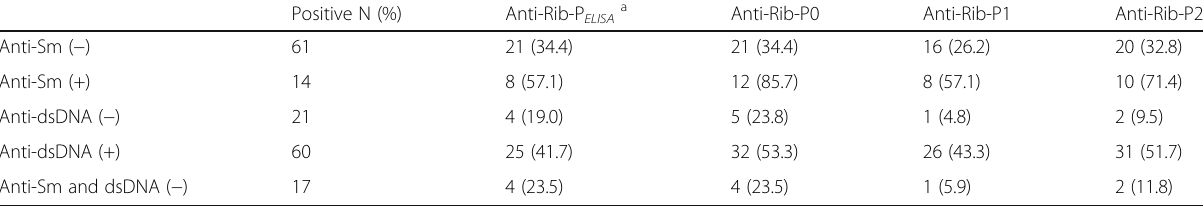
Table 2 Diagnostic benefit of autoantibodies against ribosomal P proteins Positive N (%)